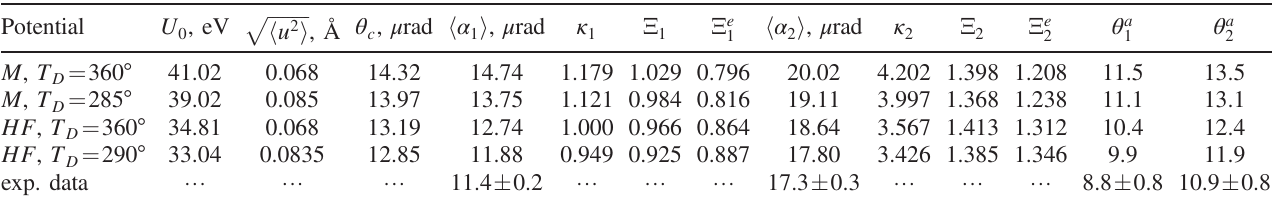
TABLE I. Characteristics of germanium crystal and volume reflection and channeling processes for (110) plane. In the 1st column the model of potential (M — Moliere, HF — Hartree-Fock) and Debye temperature are presented. Other designations are: U 0 and θ c are the potential barrier and critical angle of channeling (for 400 GeV) in straight crystal; the value h u 2 i is defined by Eq. (2); h α 1 i and h α 2 i are the mean angle of volume reflection (at R ¼ 2 . 3 m and 8.2 m, correspondingly); Ξ 1 and Ξ e 1 are the values of generalized function in Eq. (3) at R ¼ 2 . 3 m from calculation and experimental results, correspondingly, and Ξ 2 and Ξ e 2 are the same as previous but at R ¼ 8 . 3 m; κ κ R ¼ 2 . 3 m and 8.2 m, correspondingly; θ a θ a 1 and 2 are the values of generalized variable at 1 and 2 the angle acceptance of bending plane at R ¼ 2 . 3 m and 8.2 m, correspondingly. Experimental data from